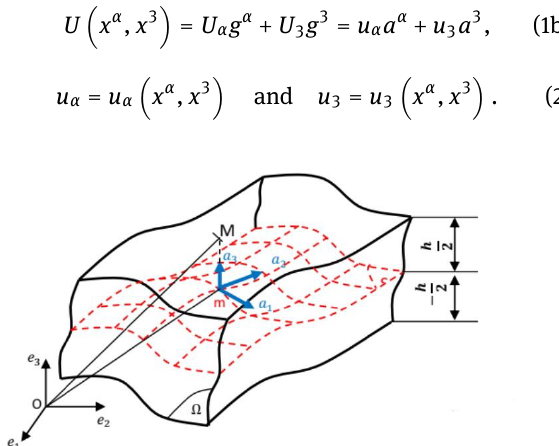
Figure 1: Domain of shell Ω